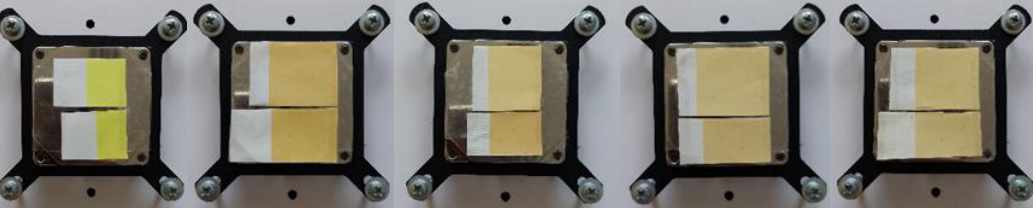
Figure 10. Visual presentation of thermochromic prints of cold activated TC ink OY-12 at 8 °C, be- fore and after exposure of samples to UV radiation unexposed and exposed (6, 12, 18, and 24 h) (above CHR sample, below NMF sample).